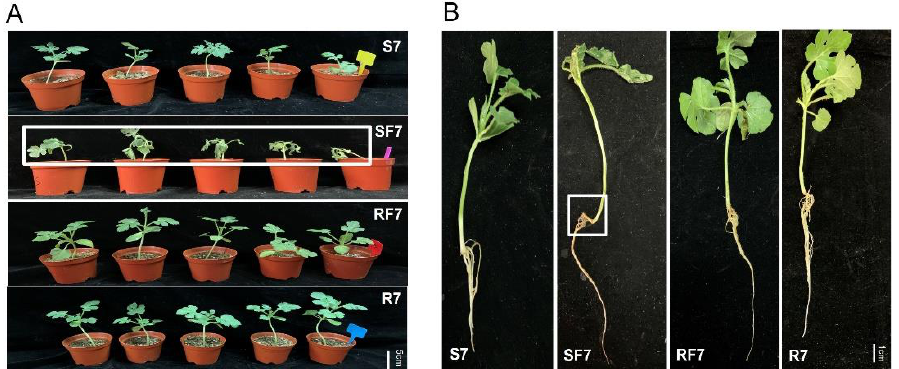
Figure 1. Comparison analysis of watermelon performance after FON infection at 7 dpi: ( A ) Com- parison of watermelon seeding phenotype in different samples; ( B ) Comparison analysis of root phenotype in different samples.